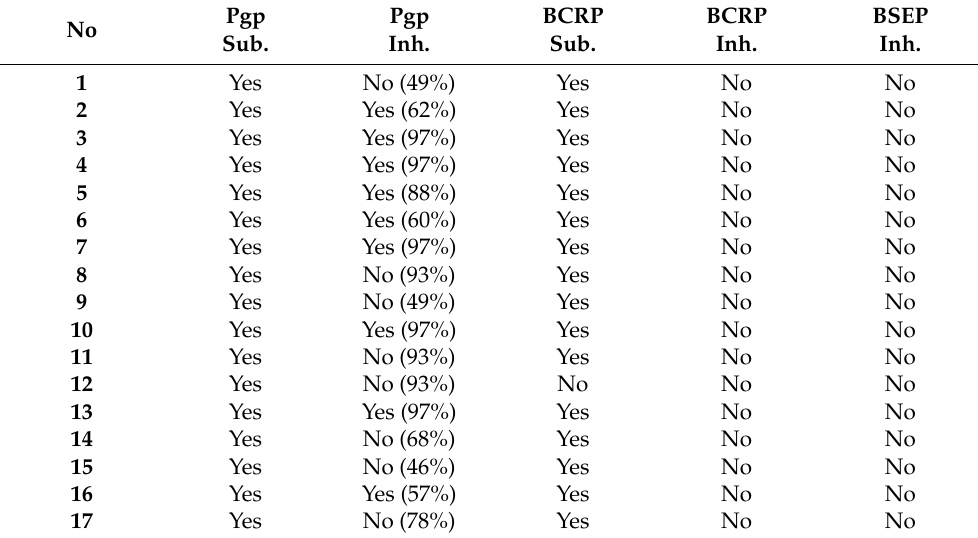
Table 9. Studies on selected transporters for the examined compounds 1 – 17